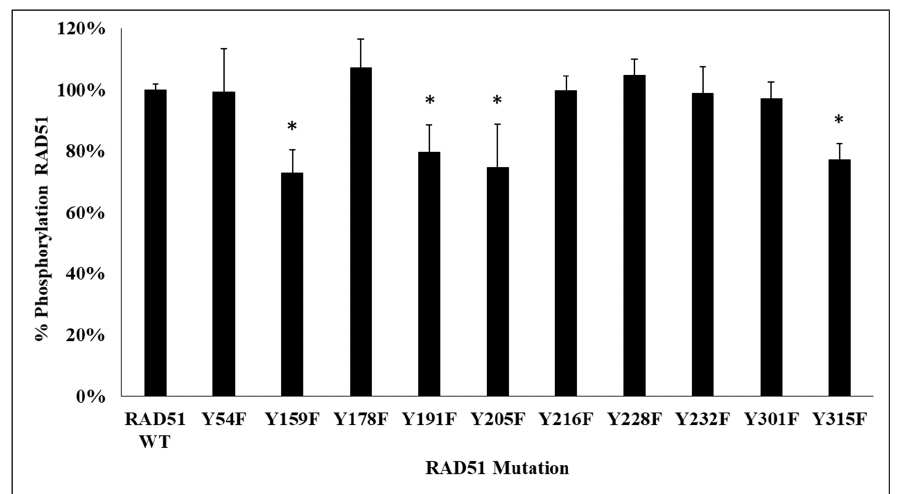
Figure 2. Decrease in RAD51 phosphorylation level in 4 RAD51 mutants. RAD51 WT protein and all non-phosphorylatable mutants of RAD51 (10 µM) were purified and incubated in the presence of kinase-active c-MET (0.1 µM) and ATP (2 mM). Then, the proteins were separated by SDS-PAGE 12% gel and analyzed by western blot using anti-RAD51 and anti-phosphotyrosine antibodies. The signals were quantified with the Odyssey scanner and compared with the signal from RAD51 WT. The graph represents the phosphorylation percentage of each mutant compared to the wild protein and obtained from the quantification of blots. Each experiment was conducted three times independently ( n = 3; error bars: s.d.; * p < 0.05).